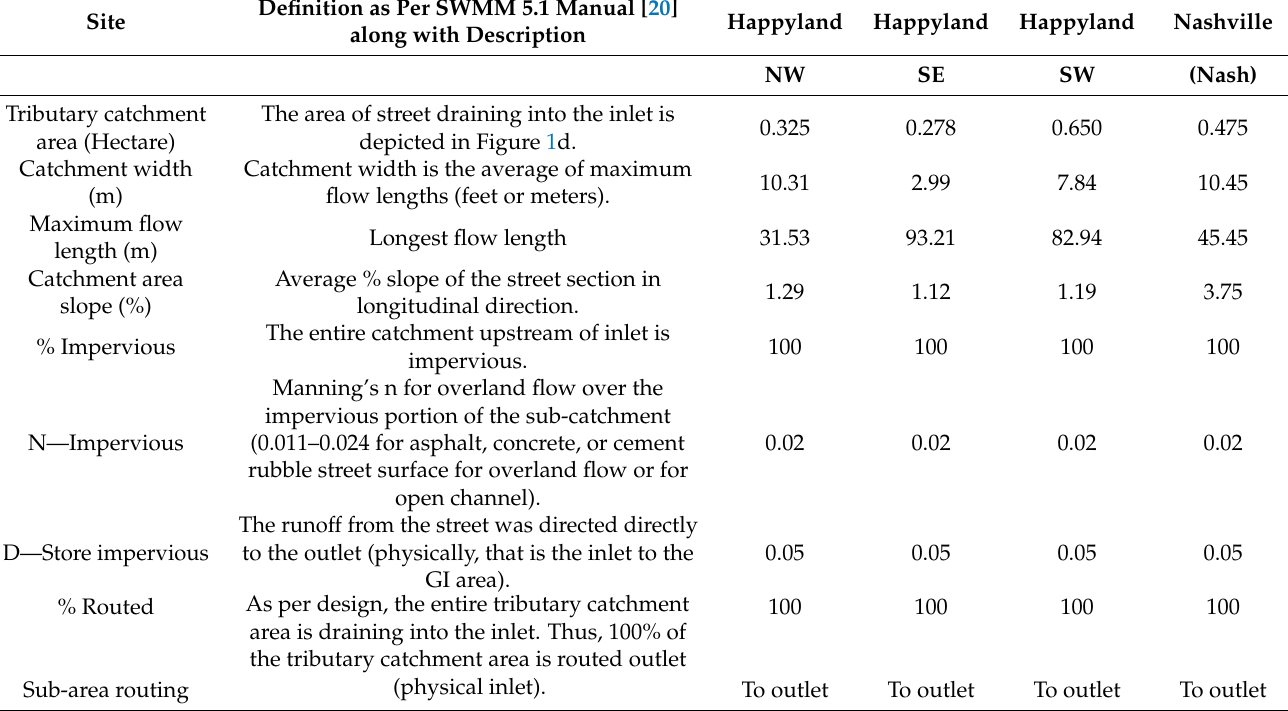
Table 4. Parameters used in SWMM runoff